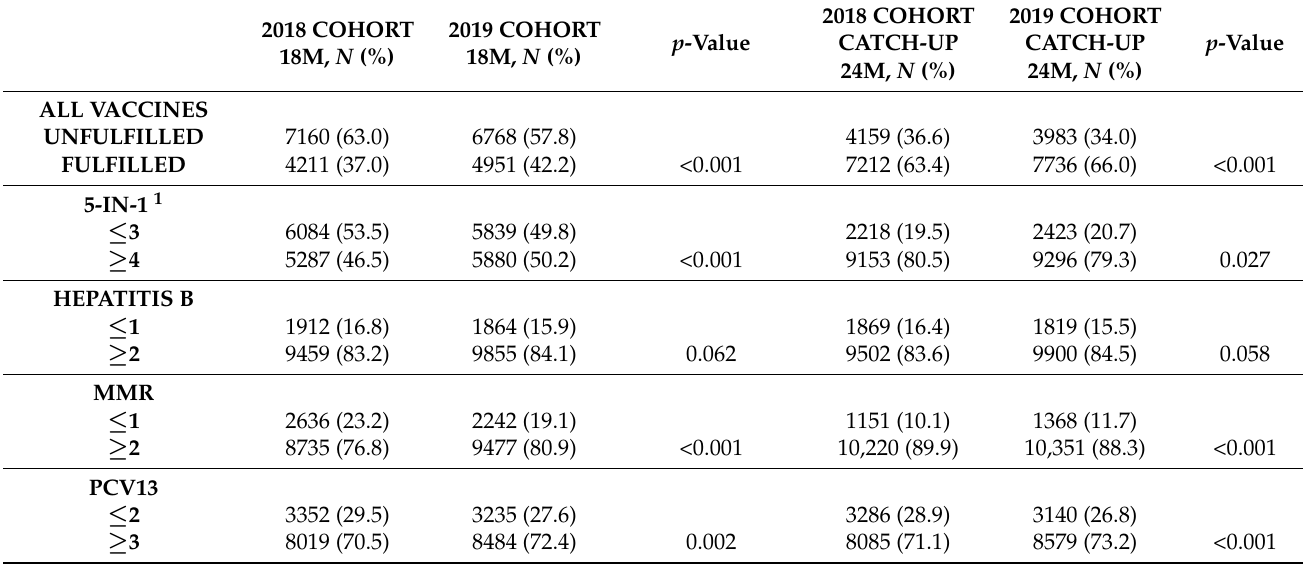
Table 3. Rate of vaccination uptake between 2018 and 2019 cohorts at both 18-month and 24-month time points; 1 5-in-1 refers to combined diphtheria, tetanus, acellular pertussis, inactivated poliovirus, and hemophilus influenzae type b vaccine.